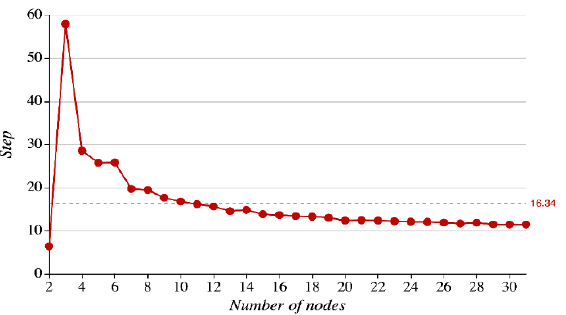
Figure 17. Relations between the number of nodes and the number of convergence steps.